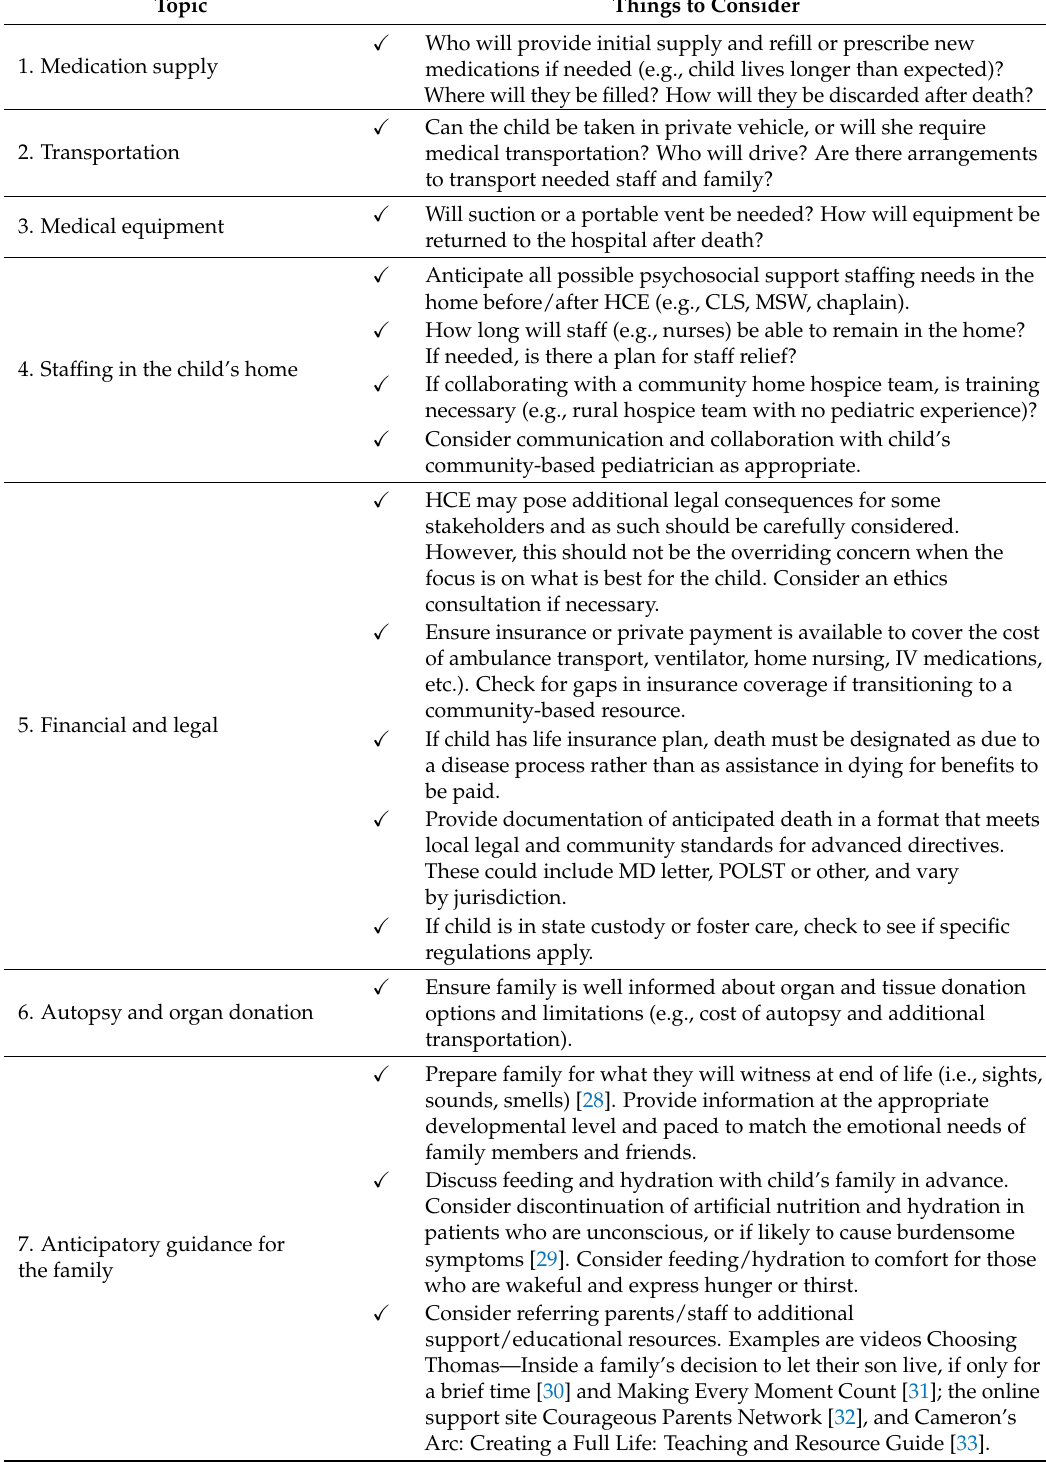
Table 2. Key Considerations Prior to Home Compassionate Extubation in Infants and Children with the Possibility of Continued Life at